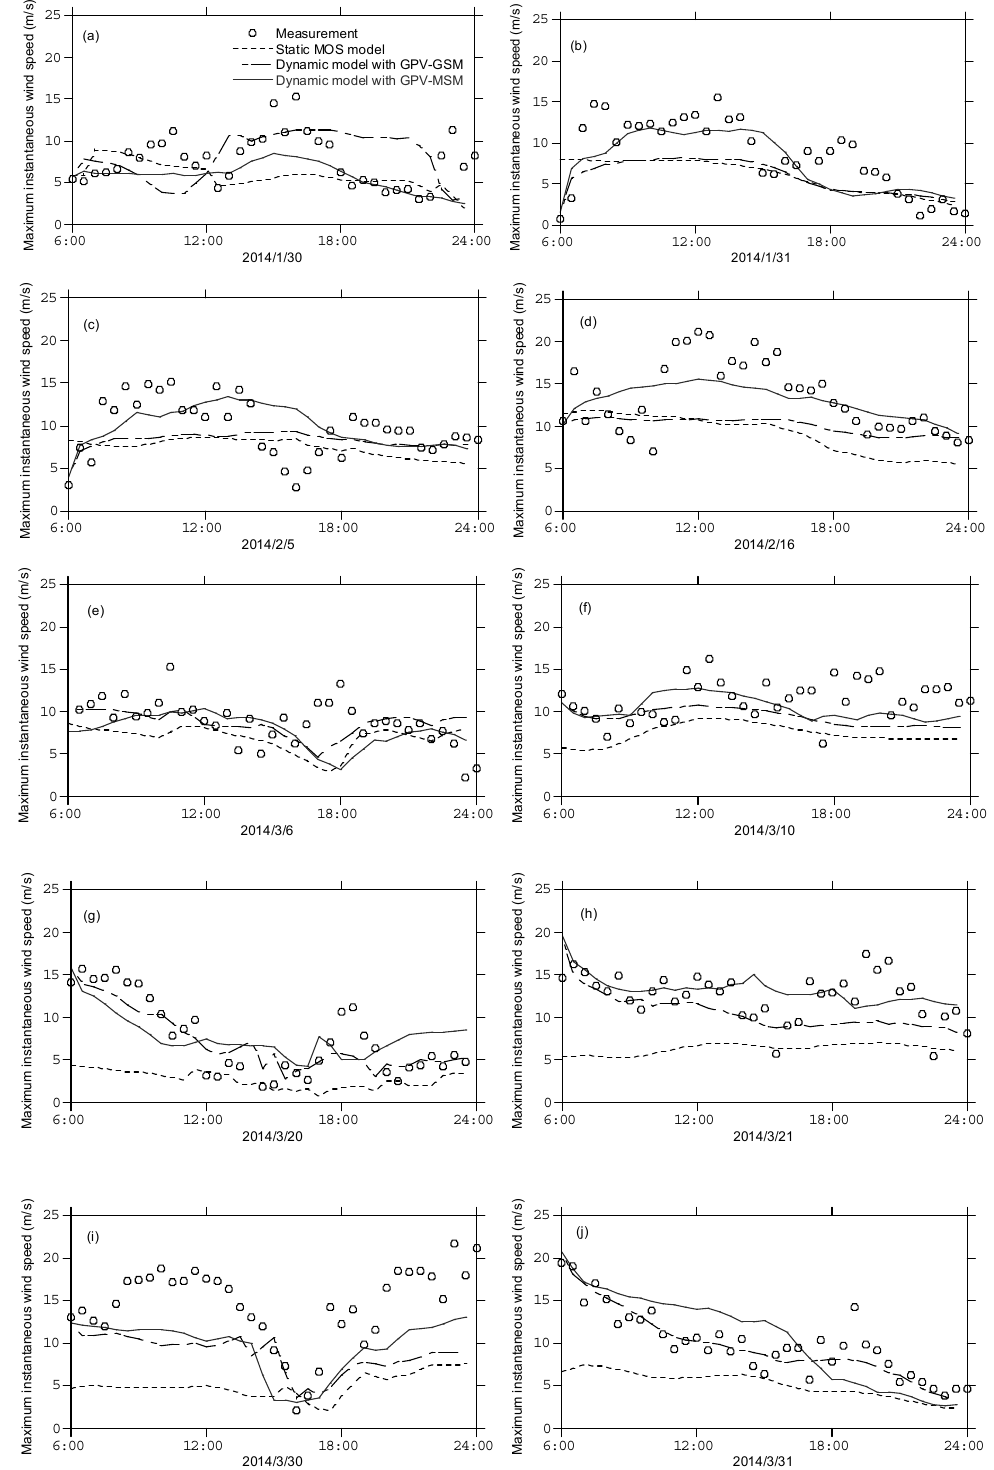
Figure 6. Comparison of measured and forecasted maximum instantaneous wind speeds predicted by the dynamic and conventional static models. The strong wind events as shown from ( a ) to ( j ) are listed in Table 2. The strong wind events ( a ) and ( i ) were caused by South-coast cyclone, while the other strong wind events were caused by Siberian High and Aleutian Low.